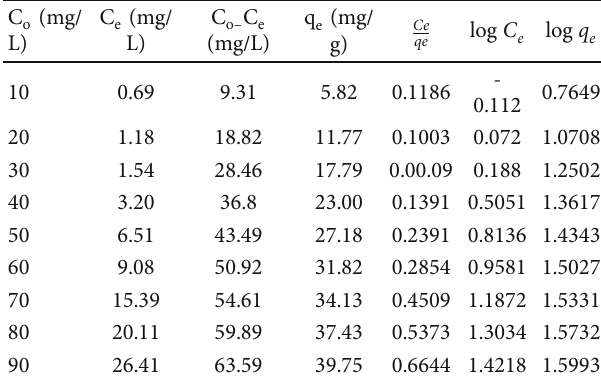
Table 12: Adsorption isotherms of Cr(VI) ion adsorption. C (mg/ o